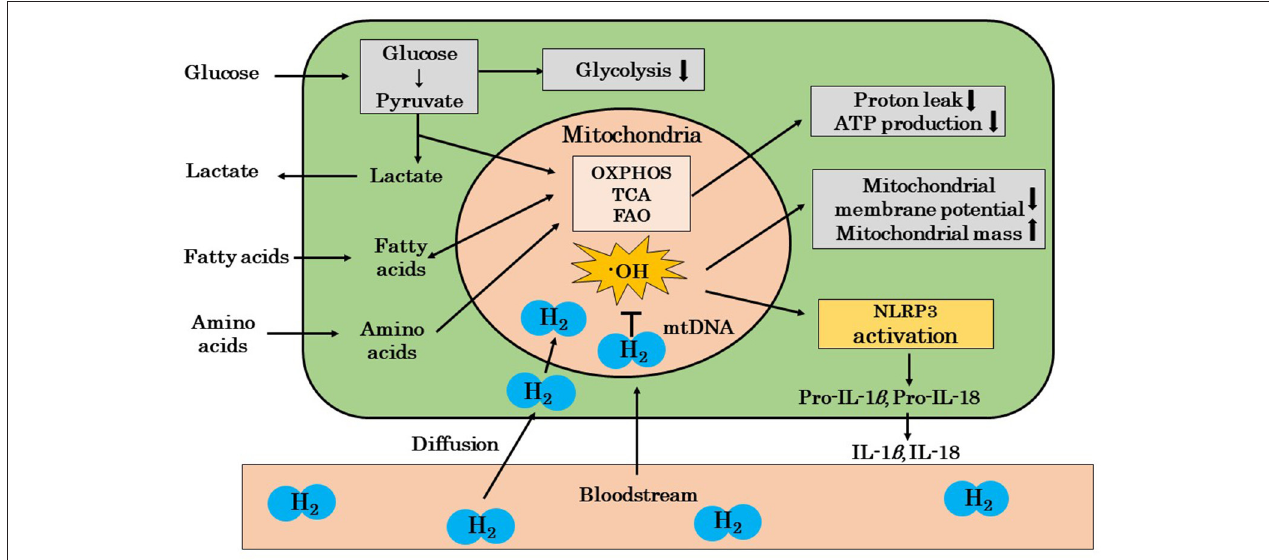
FIGURE 2 | A possible mechanism by which H 2 ameliorates mitochondrial dysfunction in ME/CFS patients. The mitochondria of ME/CFS patients show a reduced glycolytic capacity and abnormal metabolism. These mitochondria show decreased proton leakage, ATP production, and mitochondrial membrane potential and an increased mitochondrial mass. H 2 ameliorates mitochondrial dysfunction by selectively scavenging · OH, which is the cause of mitochondrial damage, and blocks the cascade from NLRP3 activation to the release of inflammatory cytokines, such as IL-1 β and IL-18. H 2 , molecular hydrogen; ME/CFS, myalgic encephalomyelitis/chronic fatigue syndrome; · OH, hydroxyl radicals; OXPHOS, oxidative phosphorylation; TCA, tricarboxylic acid cycle; FAO, fatty acid oxidation; mtDNA, mitochondrial DNA; IL, interleukin; NLPR3, nucleotide-binding and oligomerization domain-like receptor family pyrin domain-containing 3 (inflammasome); ↓ , decrease; ↑ ,